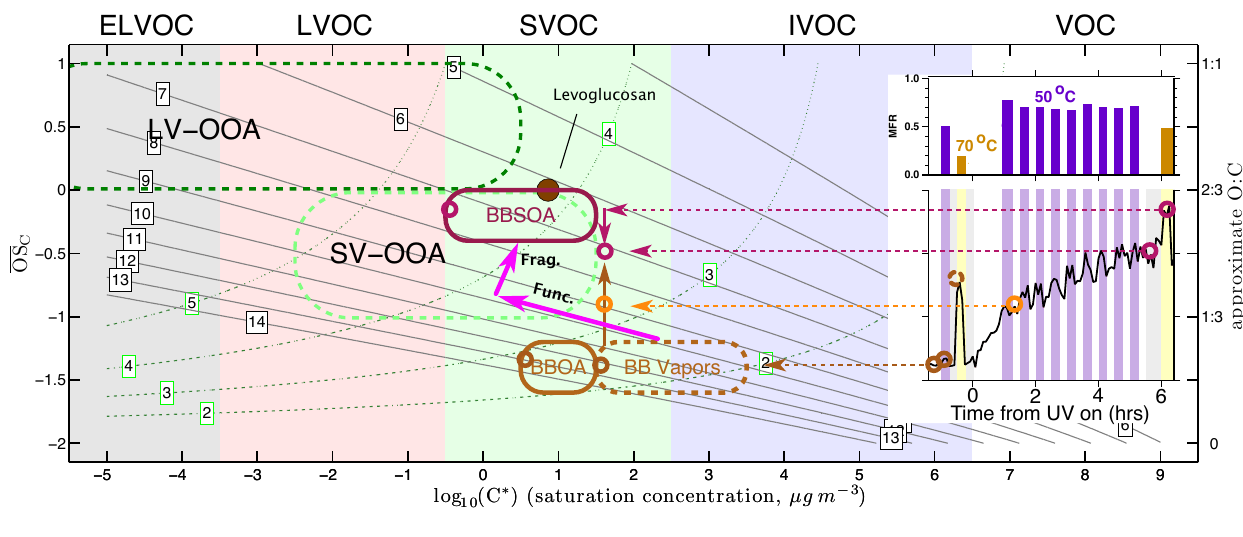
Fig. 5. Evolution of volatility and oxidation for biomass burning aerosol (BBOA) subjected to photochemical oxidation by OH radicals. The inset shows the time evolution in the lower panel (registered to the O:C-axis) while the upper panel shows the mass fraction remaining in a 16 s thermodenuder operating frequently at 50 ◦ C (blue stripes) and at the beginning and end of the experiment at 70 ◦ C (gold stripes) as well. Horizontal dashed lines show the translation of these data to the 2-D-VBS space. The contours suggest a mixture of fresh BBOA with secondary BBSOA (see text). Contours are carbon number (gray) and oxygen number (dashed green) from Donahue et al.